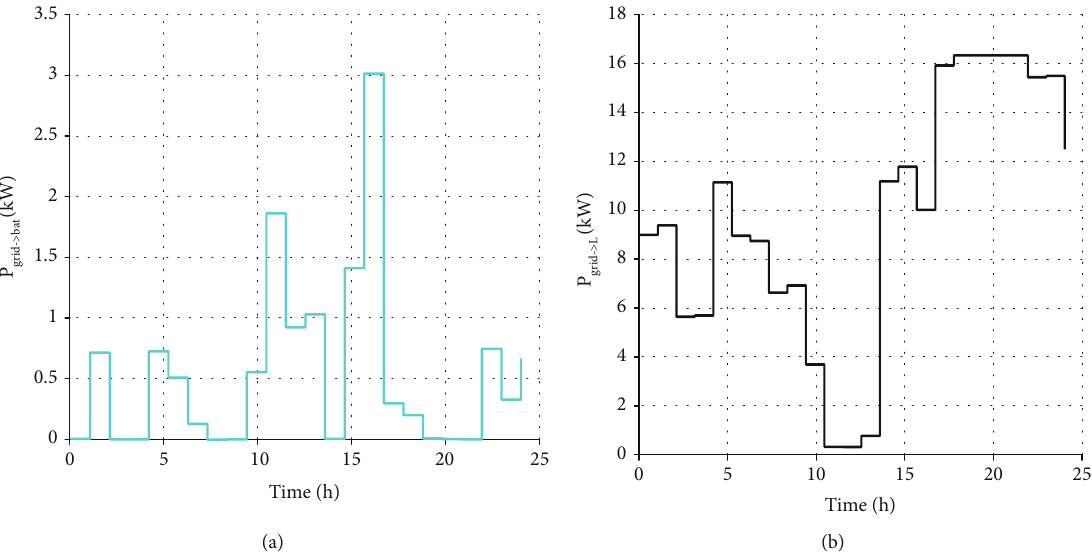
Figure 22: (a, b) Discharged power from grid to the battery and load by the FMINCON algorithm, respectively.